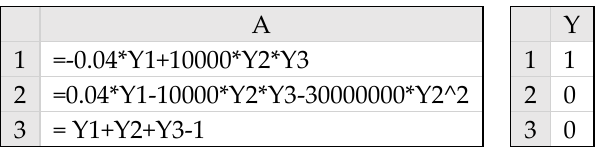
Figure A1. Spreadsheet input model for equation system A2.